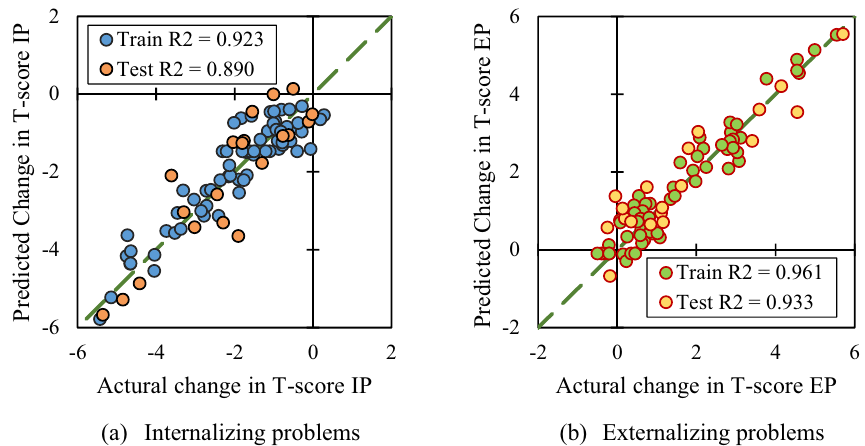
Figure 4. The designed ANFIS network perfomance in predicting changes in T-score due to different speech therapy approaches.